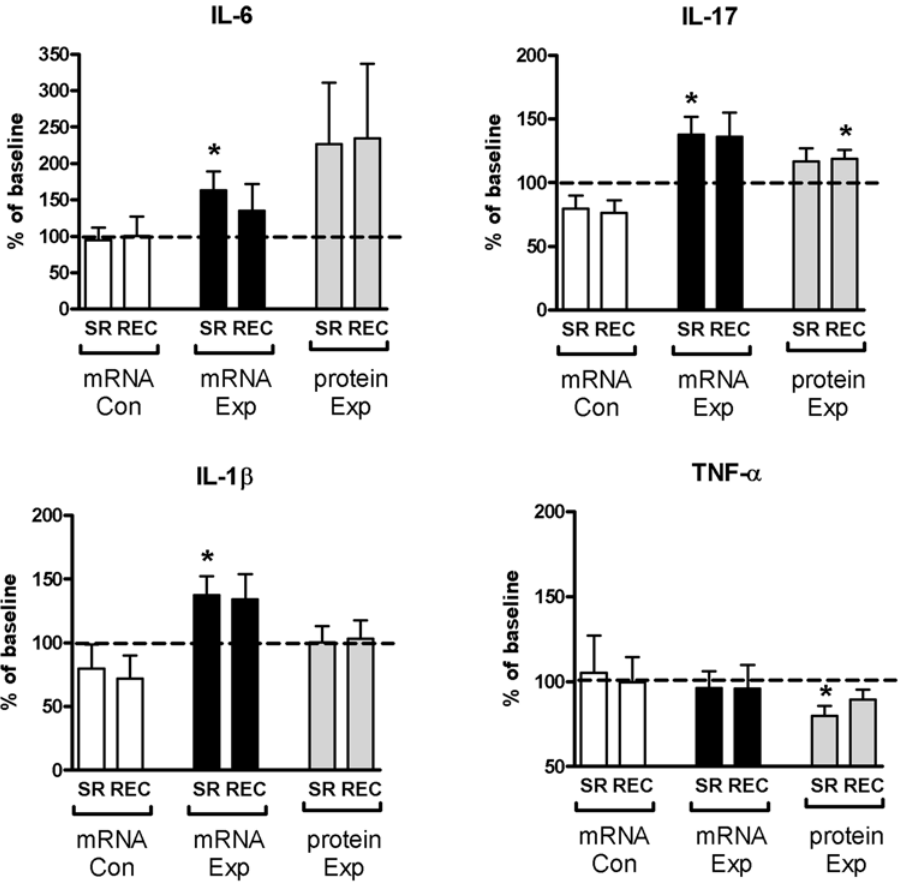
Figure 3. Cytokine mRNA and protein expression. Cytokine mRNA and protein expression of phytohaemagglutinin (PHA, 45 m g/mL) activated PBMC. SR=sleep restriction, REC=recovery, Con=control group, Exp=sleep restriction group. Data are expressed as percentages of participant’s individual baseline values (mean 6 SEM). * p , 0.05. doi:10.1371/journal.pone.0004589.g003 PLoS ONE |